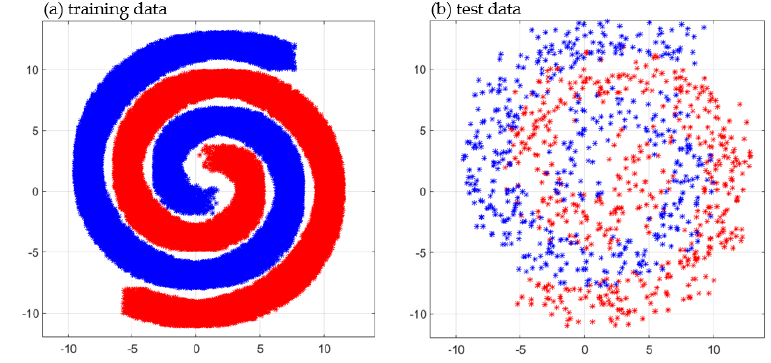
Figure 4. Spiral data sets: ( a ) Training data samples and ( b ) test data samples.